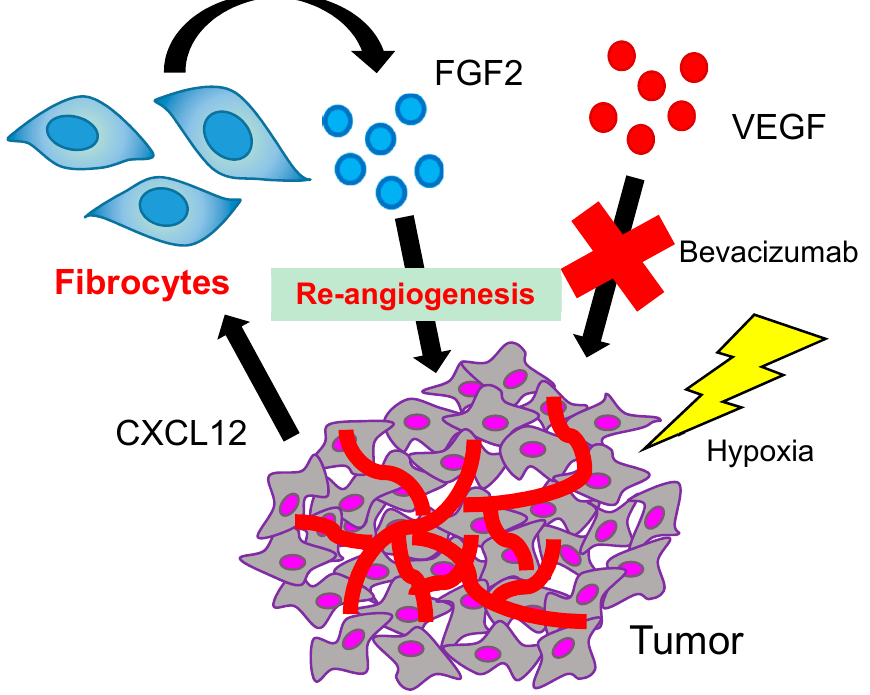
Figure 1. The possible role of fibrocytes in resistance to anti-angiogenic therapy. The hypoxic condition resulting from bevacizumab treatment could lead tumor cells to produce CXCL12, which would in turn prompt the fibrocytes to migrate into the tumor and produce FGF2.